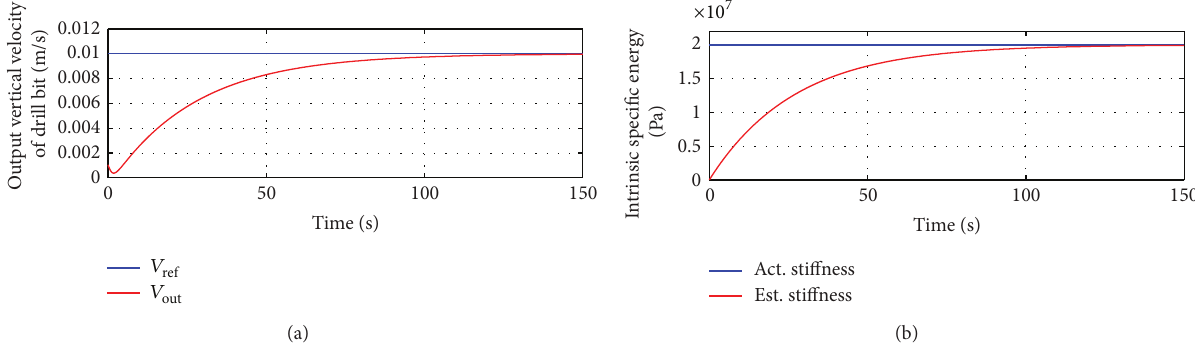
Figure 13: Response of the vertical velocity V (𝑡) (a) and the intrinsic specific energy estimate ̂𝜖(𝑡) (b) for 𝑊 0 = 2500 N, 𝜖 = 20 MPa, and = 10 8 𝛾 0